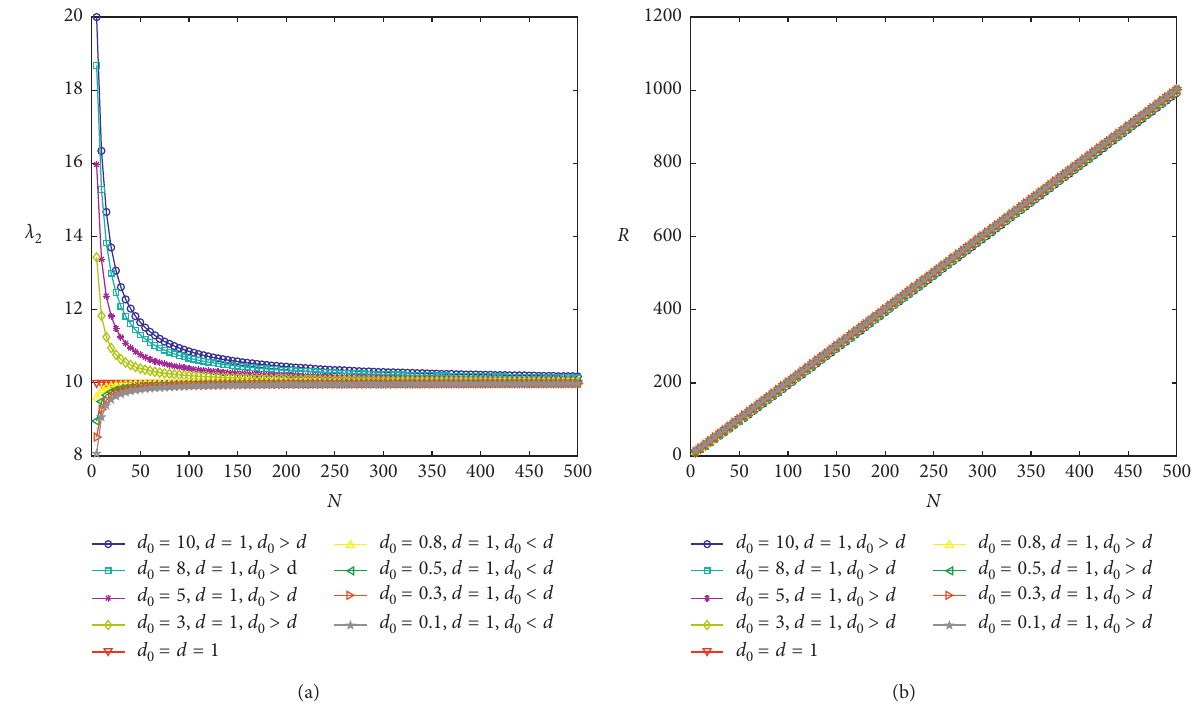
Figure 10: The synchronizability of multilayer star-ring networks vs . varying the number of nodes N ( a � 20, M � 10, d � 1, and a > Md ). (a) λ 2 with respect to varying N for different d 0 . (b) R with respect to varying N for different d 0 .